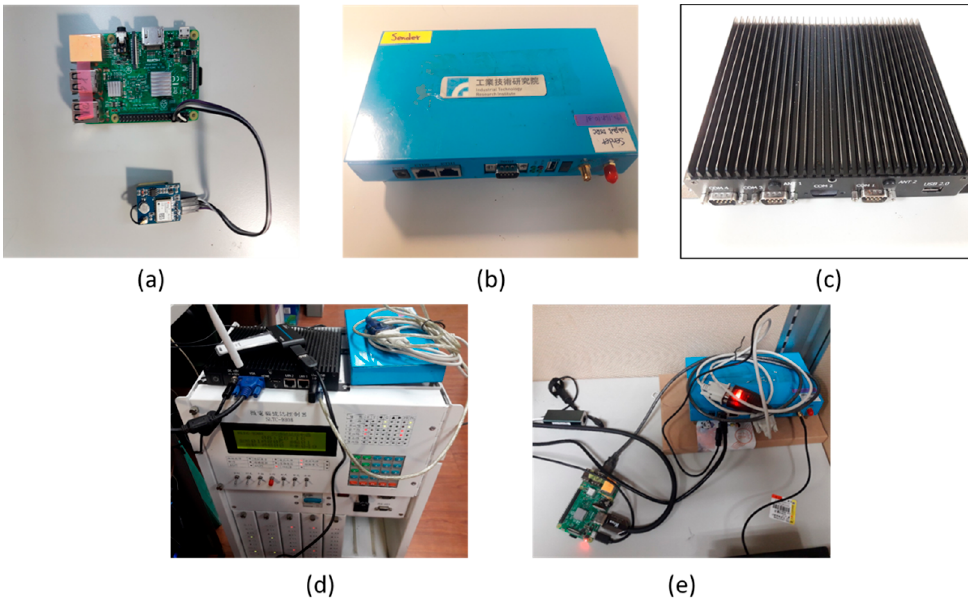
Figure 14. STSC system hardware implementation: ( a ) OBU embedded computer, ( b ) 802.11p module, ( c ) RSU controller, ( d ) RSU prototype system, ( e ) OBU prototype.